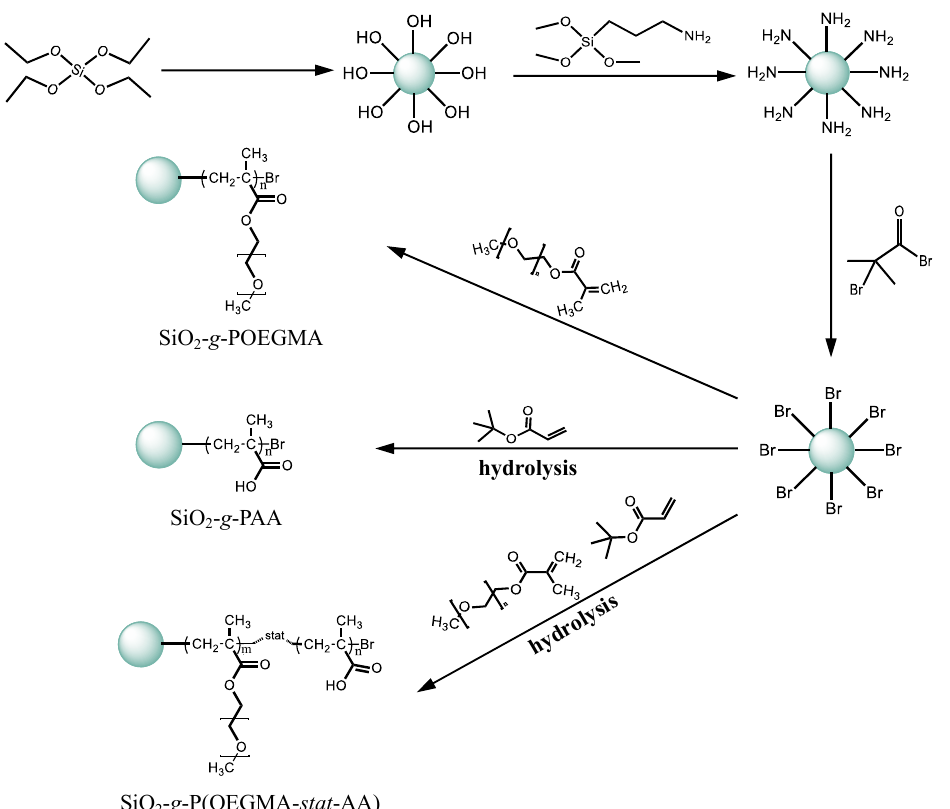
Scheme 1. Synthesis of SiO 2 - g -POEGMA, SiO 2 - g -PAA and SiO 2 - g -P(OEGMA- stat -AA) nanoparticles by SI-ATRP.